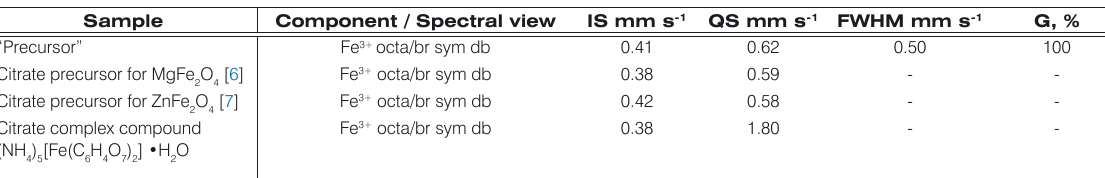
Table 2. Mössbauer parameters of different citrate precursors and citrate complex compound.